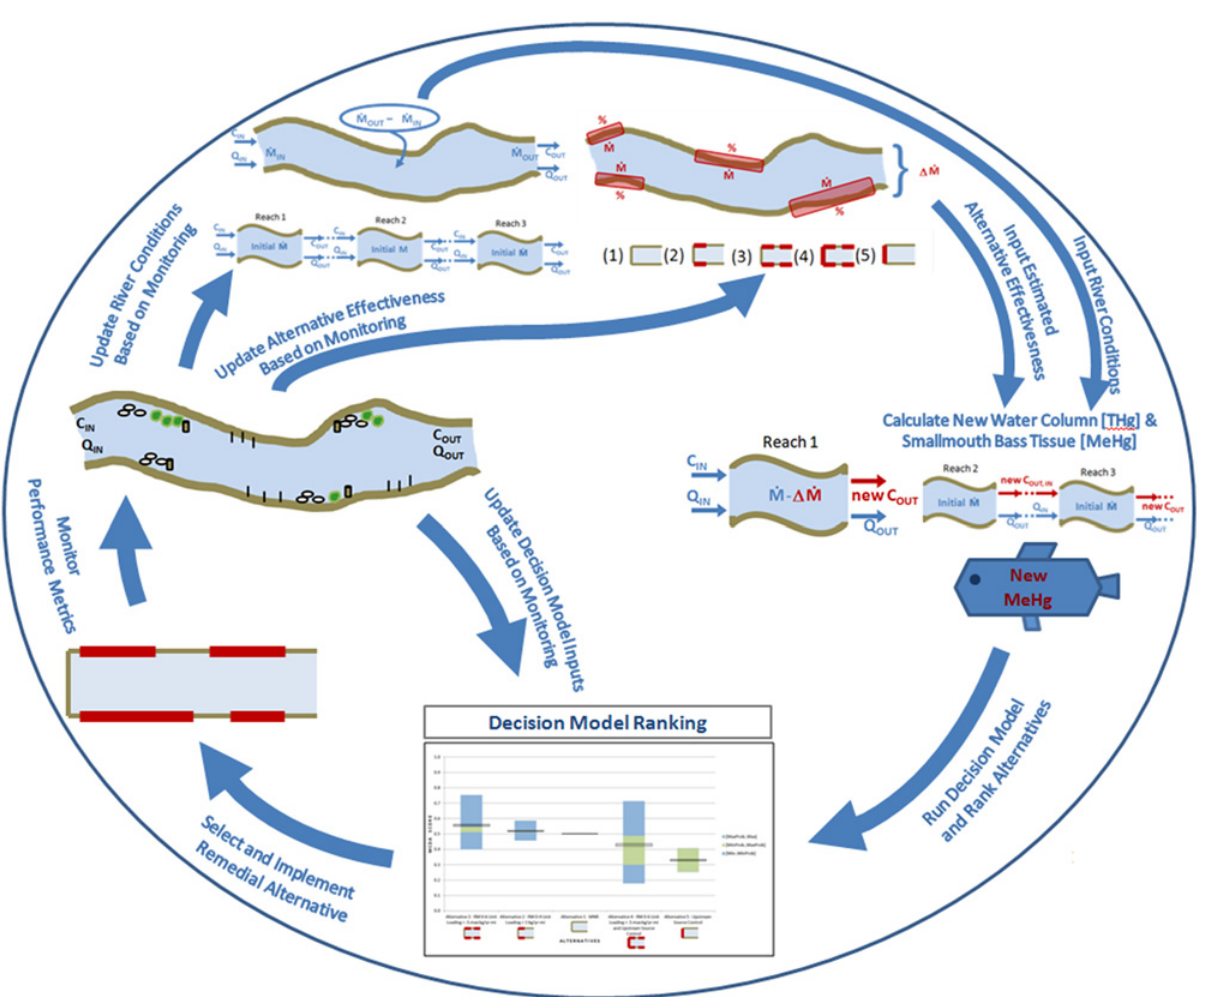
Figure 5. The process for EAM as demonstrated by the case study. Beginning at the top, the river conditions and change in total Hg loading in response to each alternative are estimated based on monitoring and pilot study results. These are then input into the mass balance to calculate the water column total Hg concentration and the smallmouth bass tissue MeHg concentration both initially and following alternative implementation. The smallmouth bass tissue concentrations are then entered into the decision model along with performance scores for the other criteria and preference weights and a relative ranking of alternatives is calculated. Based on the outcome of the decision model, an alternative is selected and implemented. Metrics that relate to parameters in the decision model are monitored according to the monitoring plan and updated as necessary. The process then repeats with the latest information gathered through monitoring and